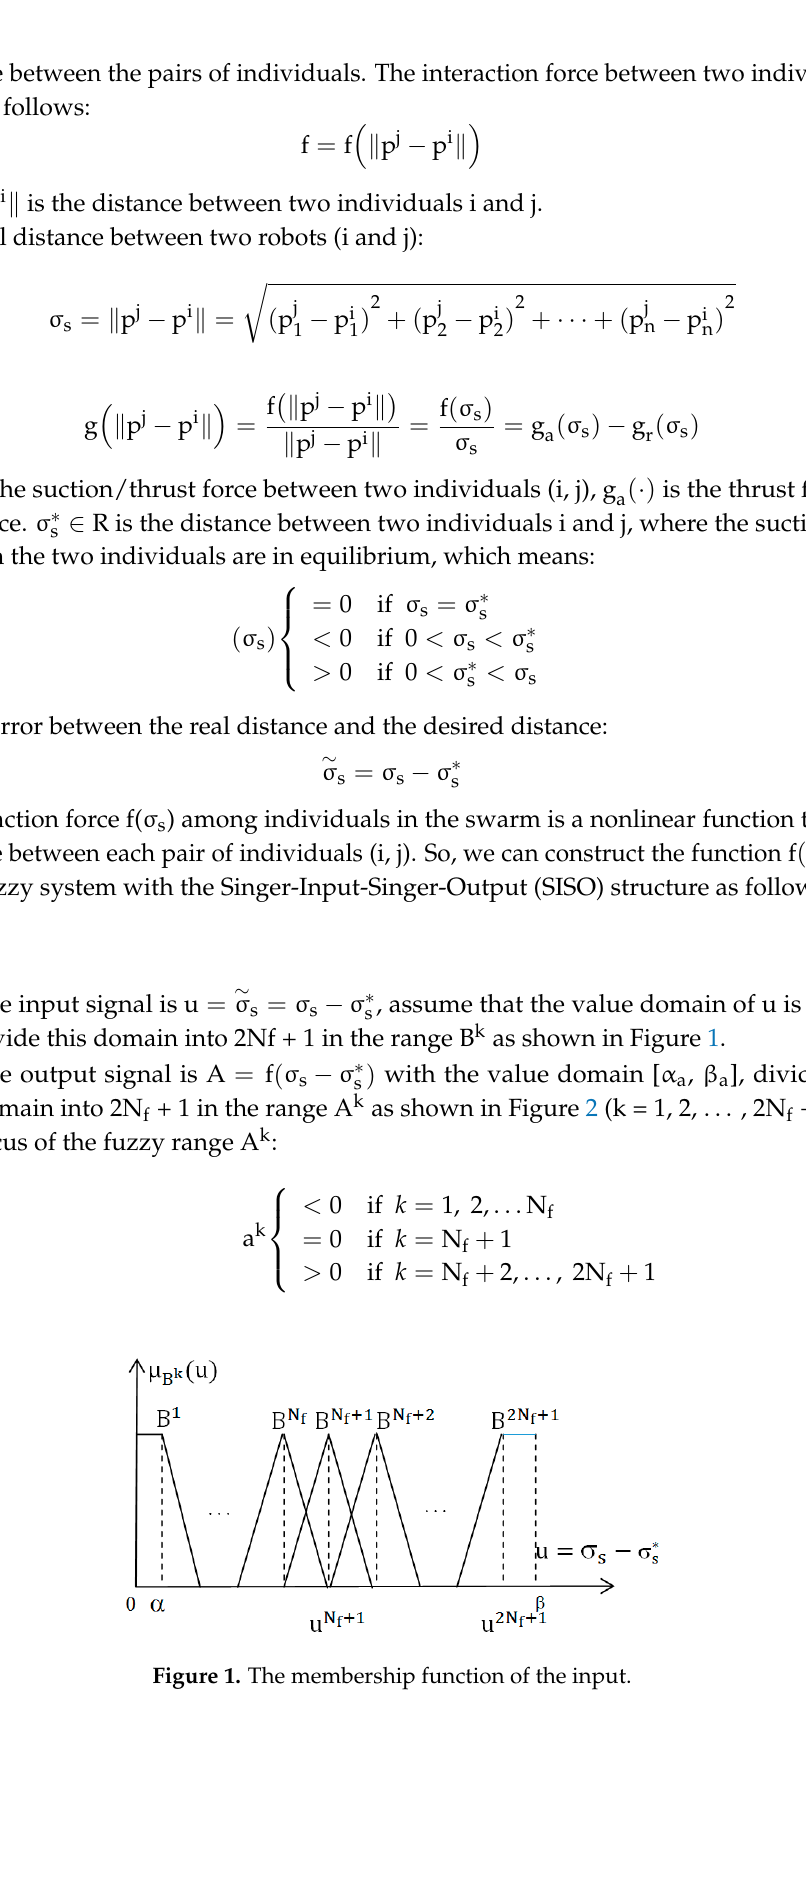
Figure 2. The membership function of the output.